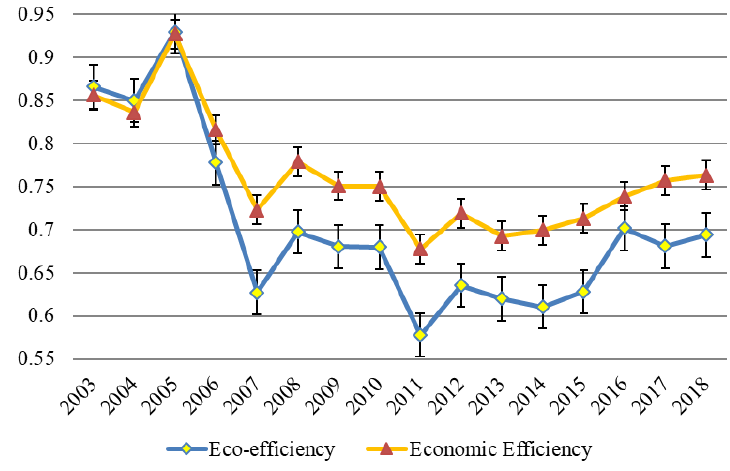
Figure 2. Eco-efficiency of aquaculture in China from 2003 to 2018.